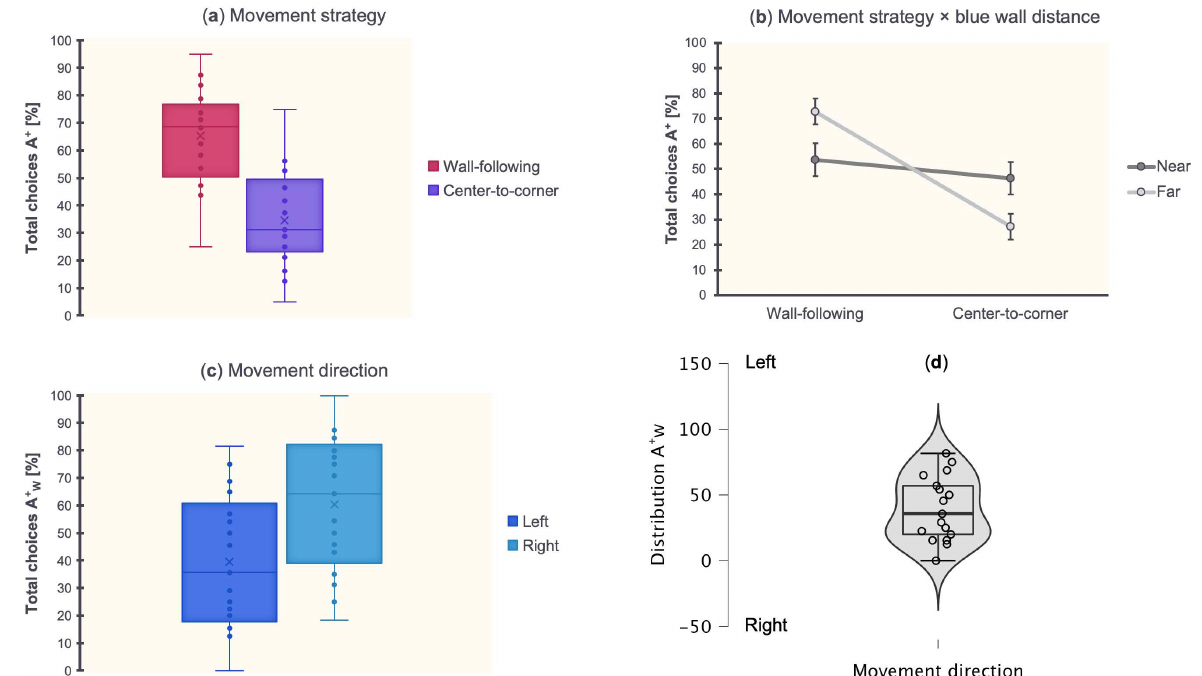
Figure 5. Results. Total choices [%] toward the correct corner position A + in relation to the use of movement strategy ( a ), movement strategy depending on blue wall distance ( b ), and direction, at the population level ( c ) and at the individual level ( d ). The dotted line indicates the chance level